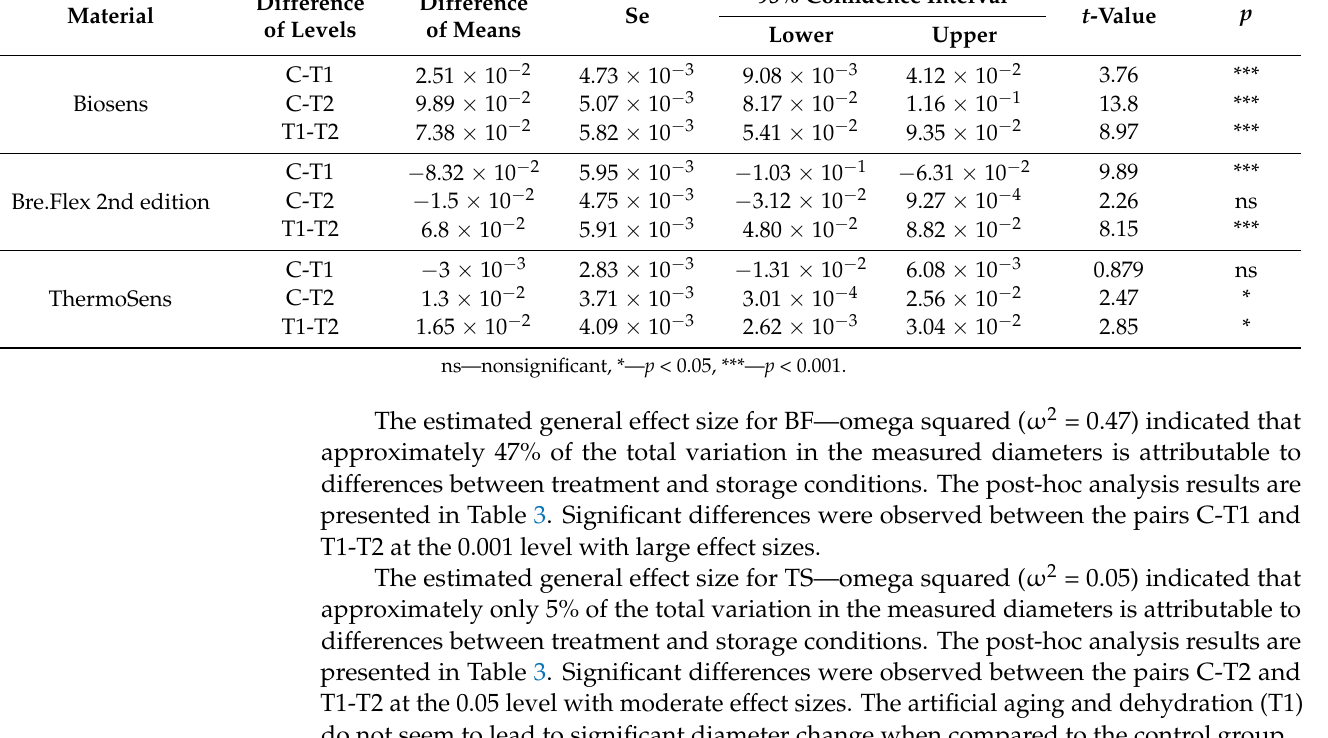
Table 2. Games–Howell post-hoc test for diameter by treatment and storage conditions for the three tested materials.